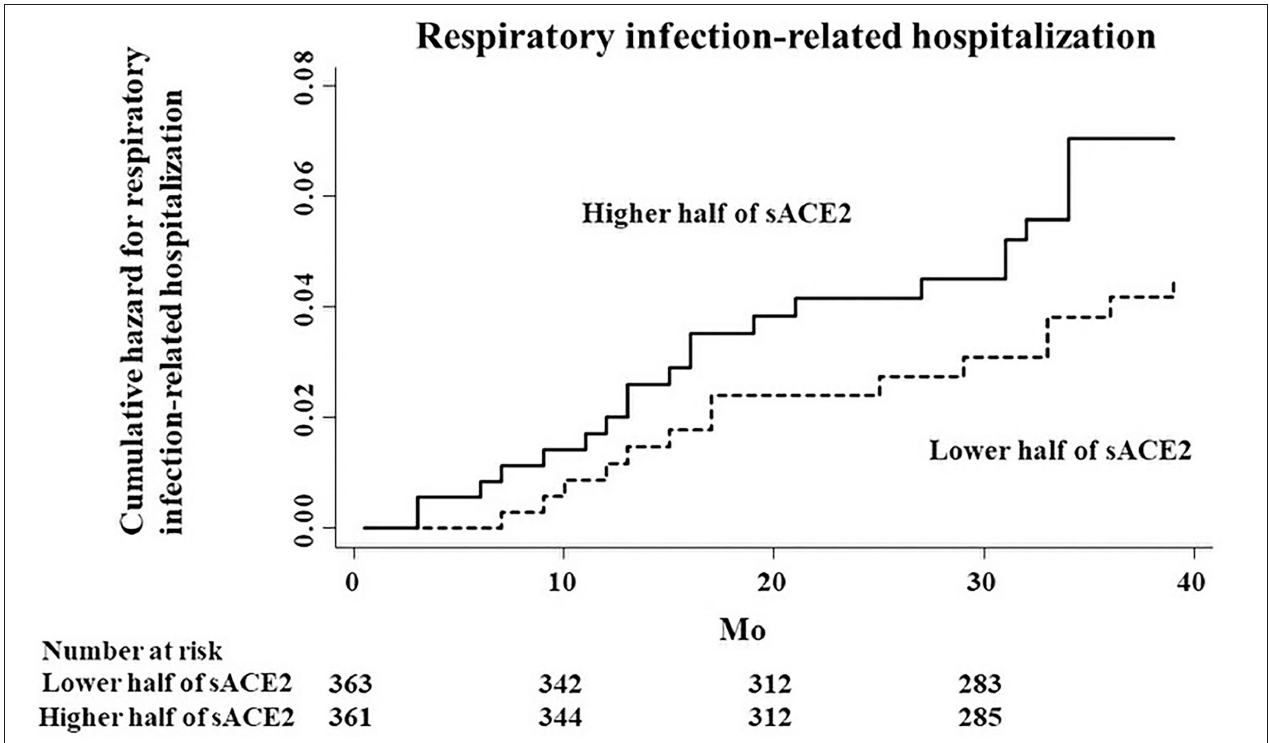
FIGURE 3 | Cumulative hazard curves for respiratory infection-related hospitalization by half of the study population according to serum ACE2 (sACE2)